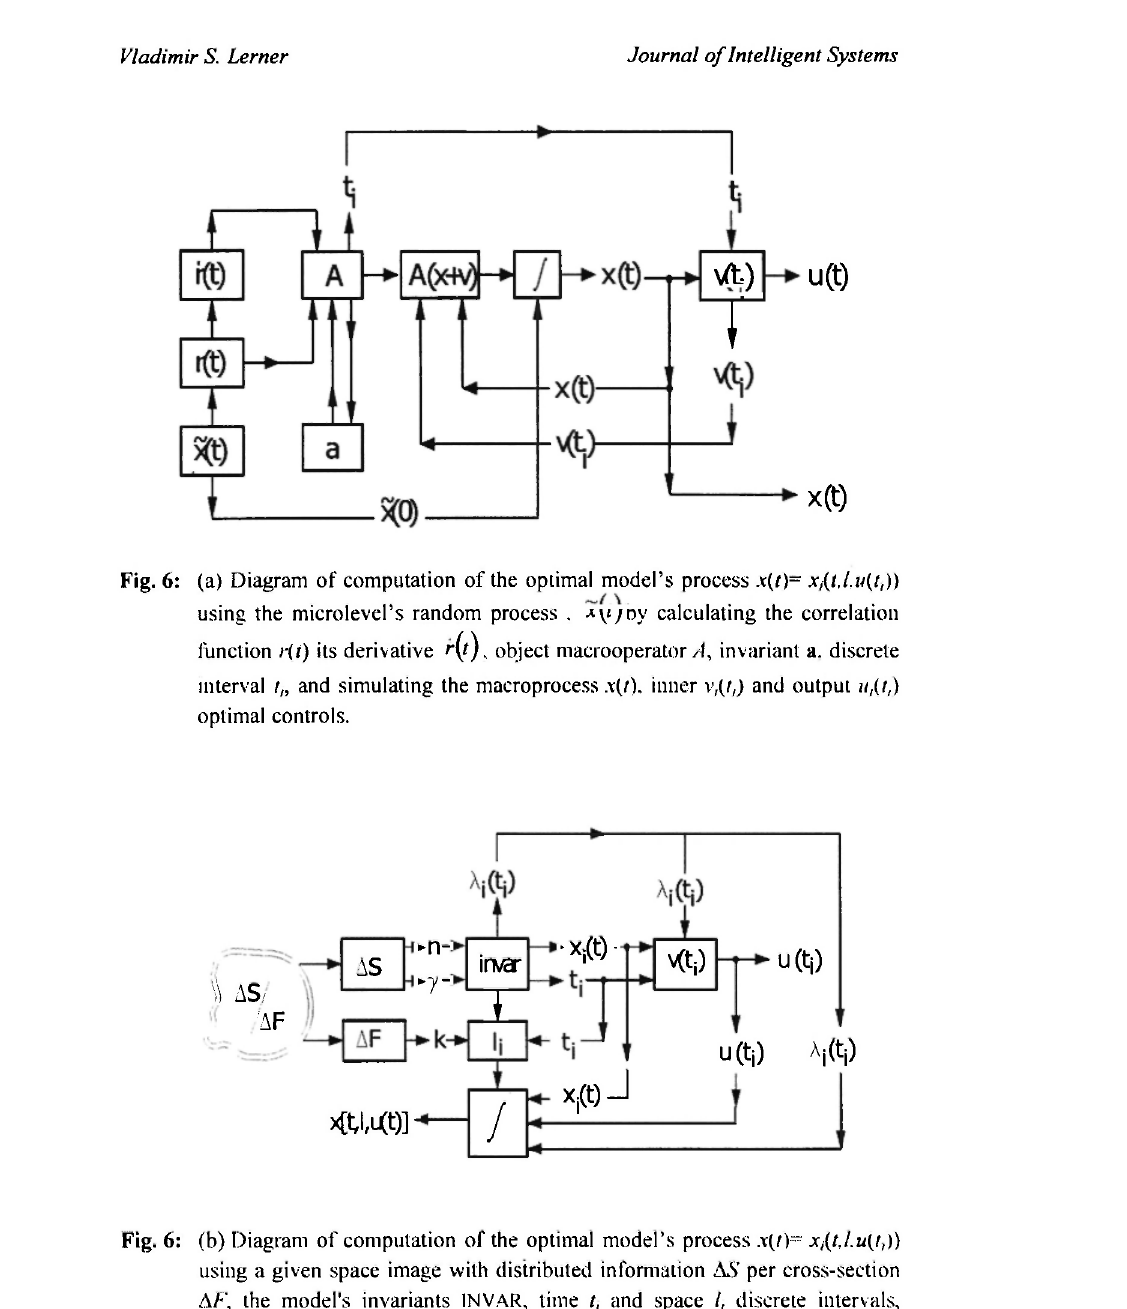
Fig. 6: (b) Diagram of computation of the optimal model's process x(t)=